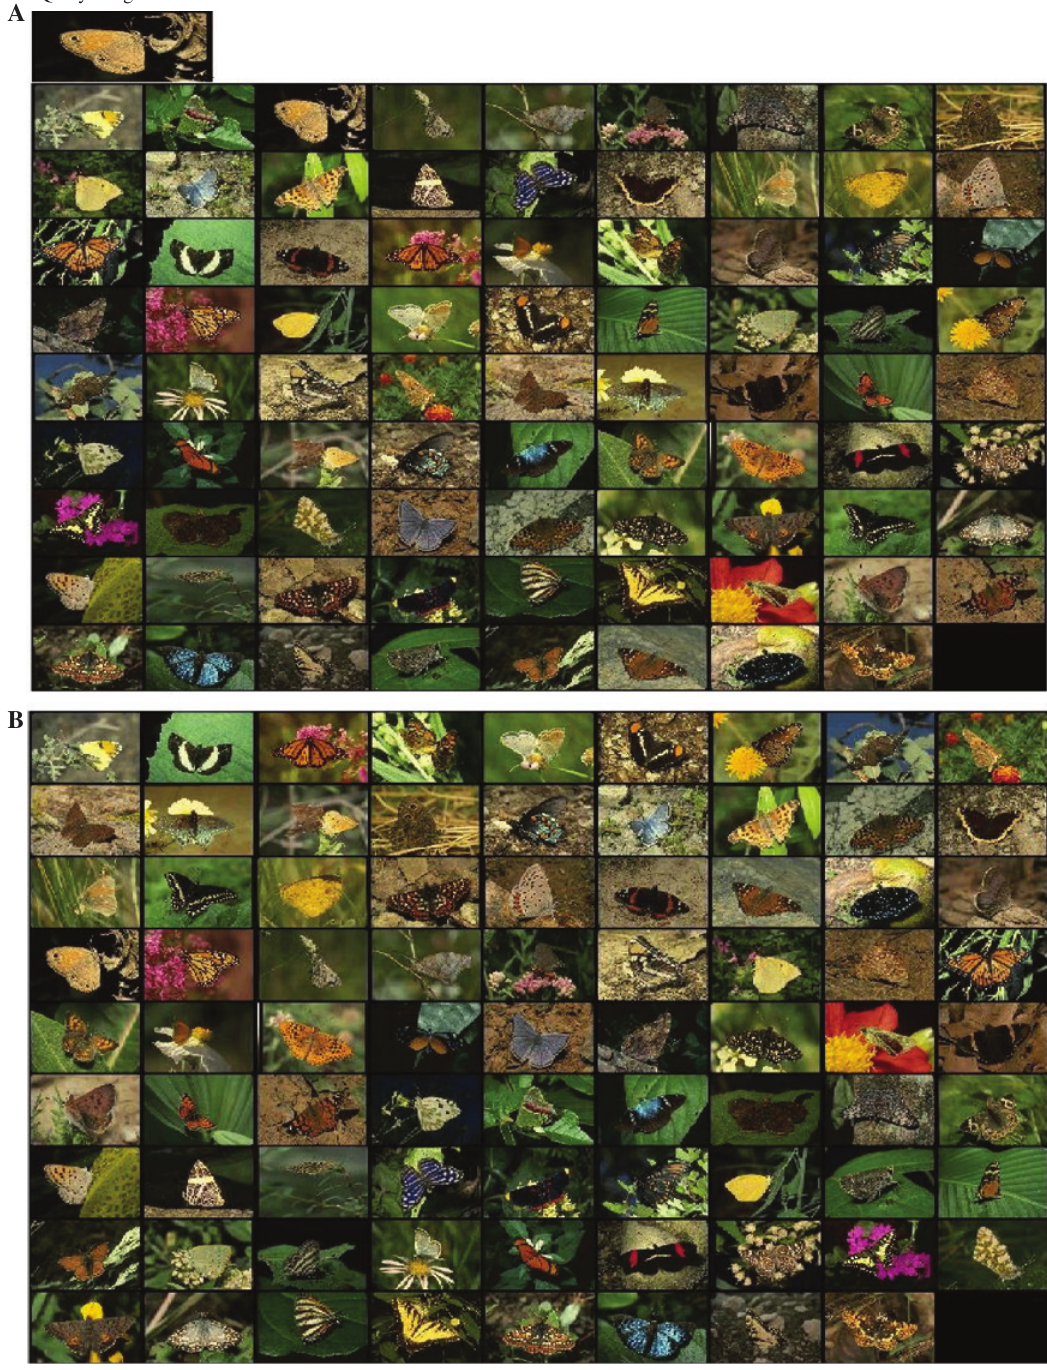
Figure 5: Retrieval Example Using Query Image (Butterfly). (A) First-level retrieval output images. (B) Re-ranked image